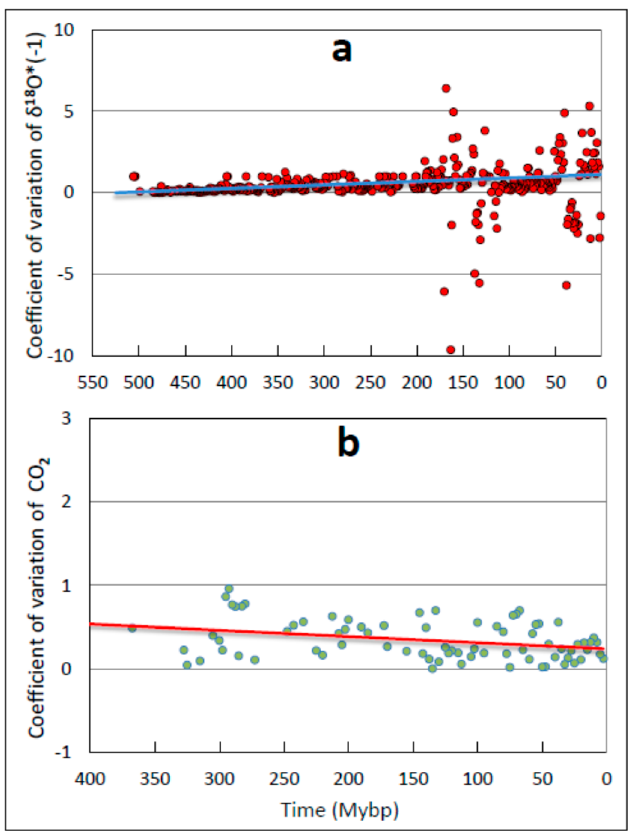
Figure 1. Variance in repeat proxy measurements over the Phanerozoic Eon. The coefficient of variation (the standard deviation divided by the mean) is plotted against sample age using data grouped in bins of 2.5 My for the temperature ( a ) and atmospheric CO 2 concentration ( b ) proxies used in this study. These graphs suggest that older samples are affected minimally by degeneration of data quality (e.g., diagenesis).